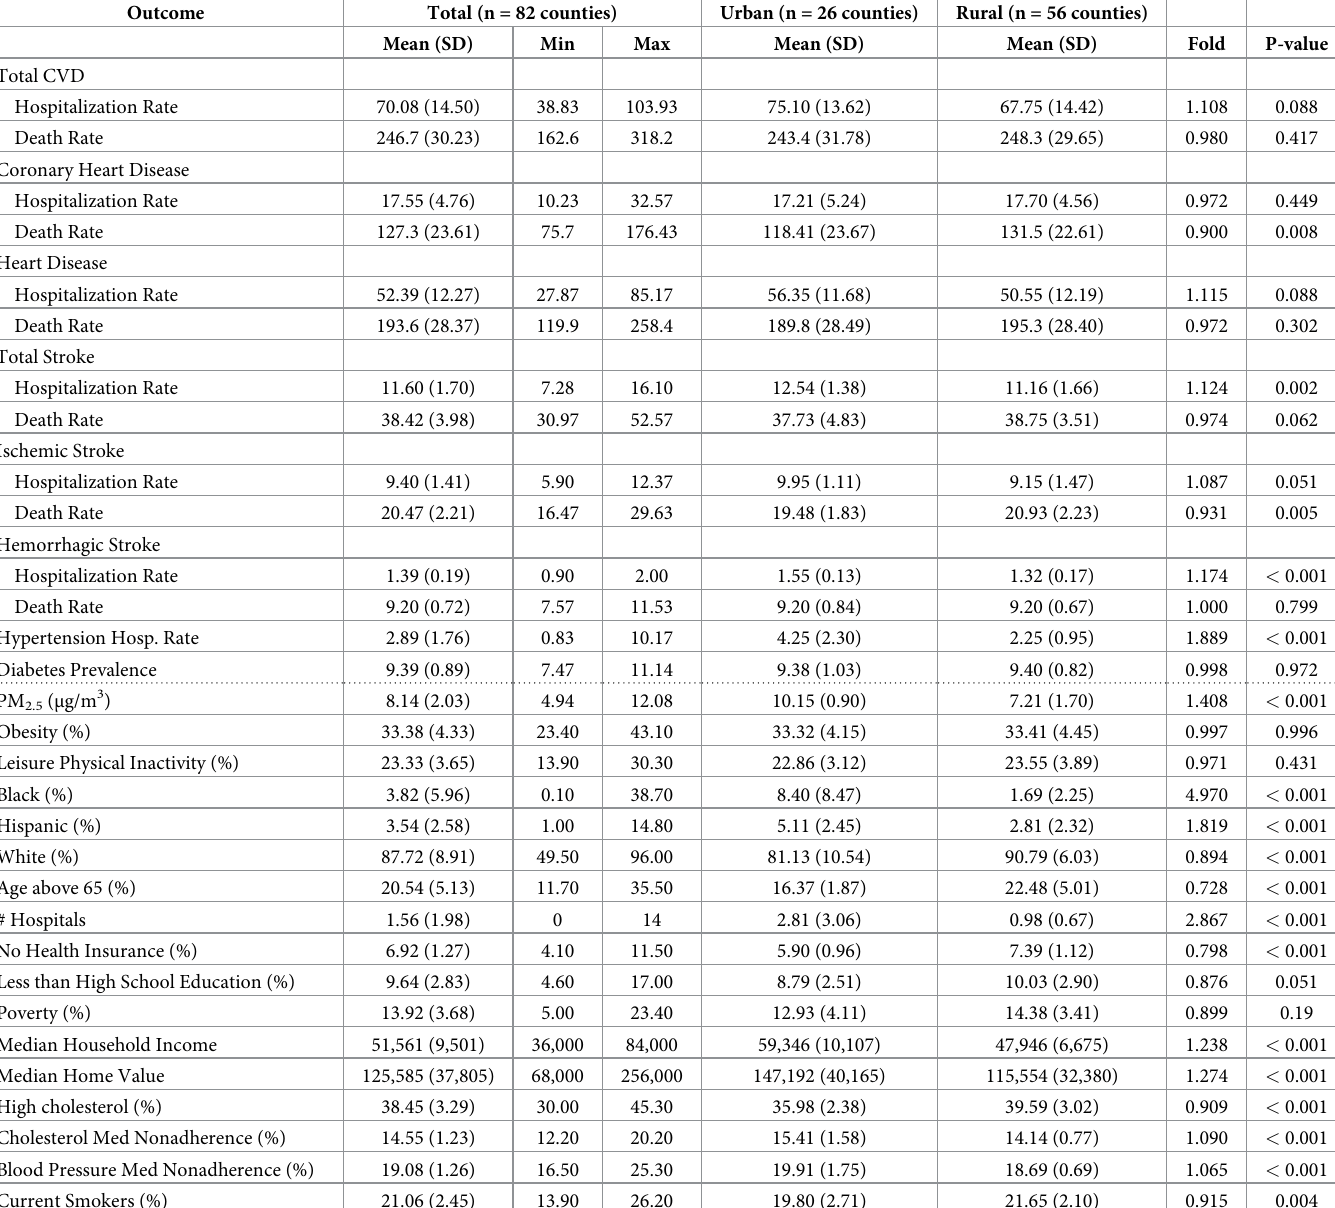
Table 2. Characteristics of Michigan counties used in the study. Mean (standard deviation), Minimum County value, and Maximum County value for all counties (Total), counties with urban status (Urban), and counties with rural or non-urban status (Rural). Fold is the ratio of urban and rural means, equal to (Urban Mean)/(Rural Mean).P-values obtained from Wilcoxon Rank Sum Tests between Urban and Rural County values are shown. P-value < 0.05 is statistically